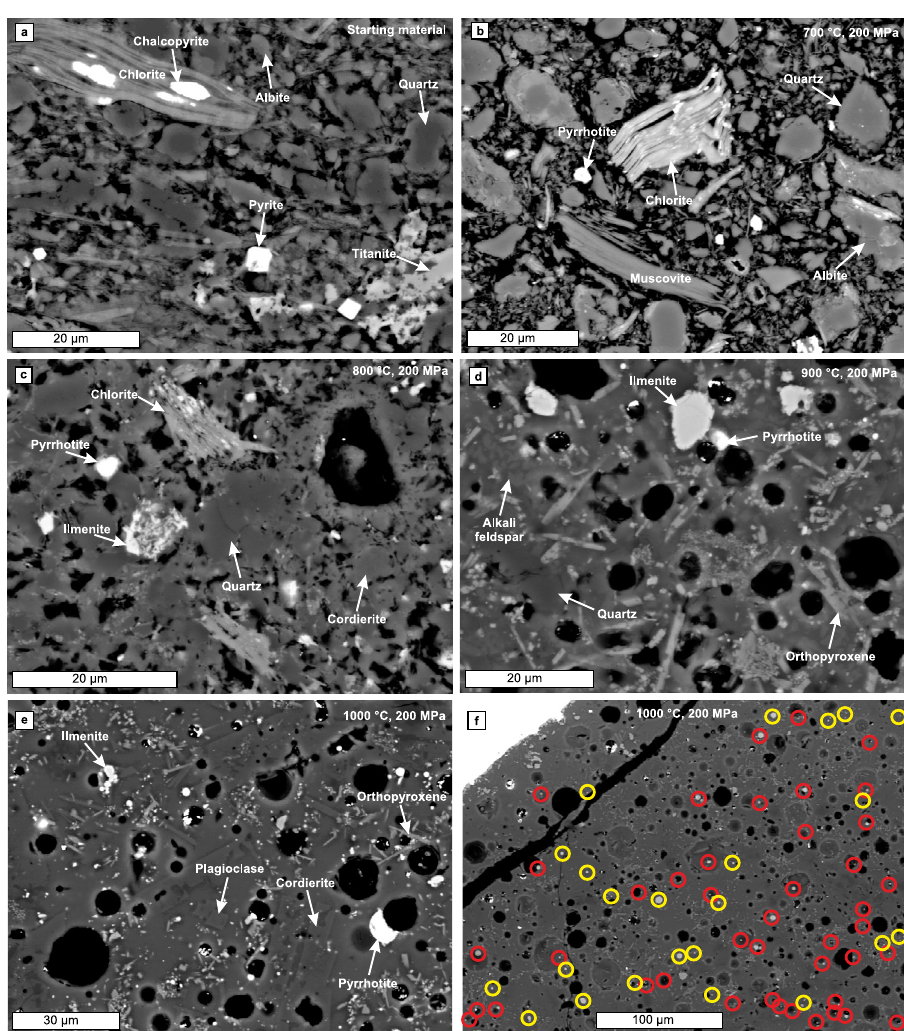
Fig. 1 Back-scattered electron images showing the textures and phases of the Virginia Formation black shale and the heating and partial melting experiments. a Starting material (polished thin section) and experiments at b 700 °C, c 800 °C, d 900 °C, and e 1000 °C. f Distribution of sulphides in the 1000 °C experiment. Red circles ( n = 43) indicate the sulphides attached to fl uid bubbles and yellow circles ( n = 23) the sulphides that are not observably attached to the bubbles in this 2D section. The black areas in the starting material ( a ) are kerogen and detached grains. The black areas in the b – f are vesicles that were fi lled with fl uid during experiment, but which was lost when the capsule was polished open. Pressure in all experiments was 200